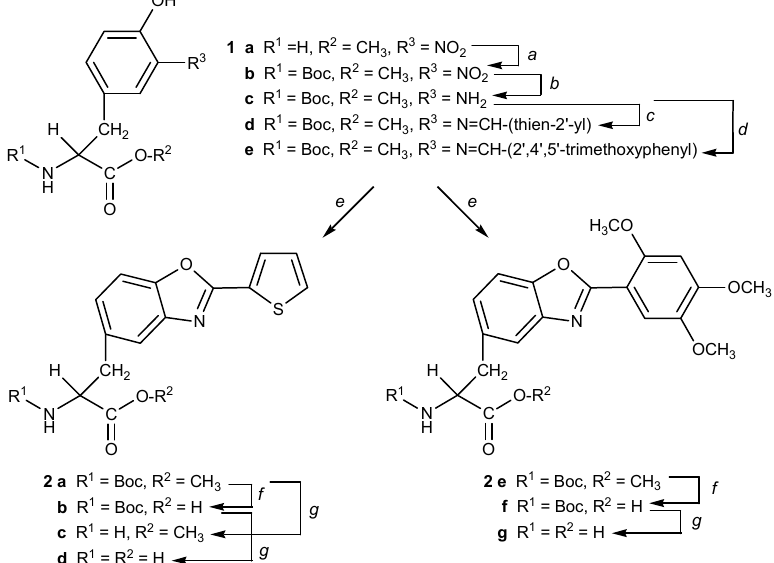
Scheme 1 . Synthesis of tyrosine derivatives 1a - e and alanine derivatives 2a - g . Reagents and